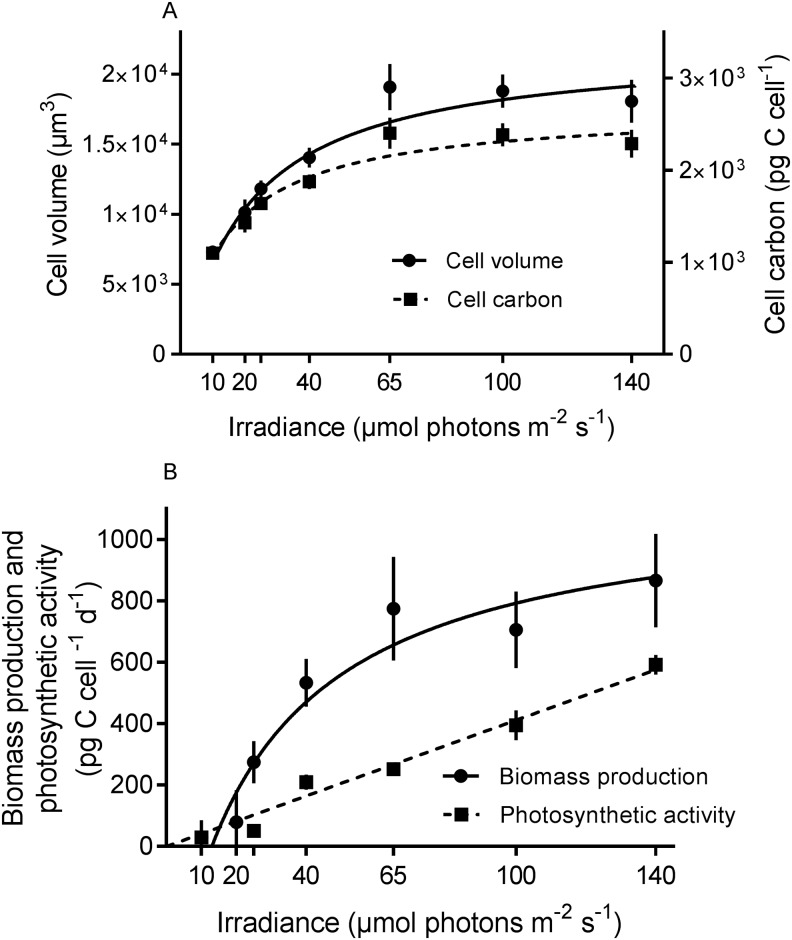
Effect of irradiance on cell volume and biomass production of Nusuttodinium aeruginosum.(A) Cell volume and cell carbon of N. aeruginosum as a function of irradiance. Data points represent means ± SE (n = 30–40). The curves were numerically fitted to Michaelis-Menten kinetics: cell volume = 22048*I/(21.04+I), R2 = 0.25; and cell carbon = 2668*I/(15.45+I), R2 = 0.28. Note different ordinate scales. (B) Biomass production (BP) and photosynthetic activity (PA) as a function of irradiances. The BP curve was numerically fitted to Michaelis-Menten kinetics: BP = 1144*(I-13)/(38.62+(I-13)), R2 = 0.93. The data for PA were fitted to a linear line, R2 = 0.97. Data for biomass production are the same as in Figs 2A and 3A.